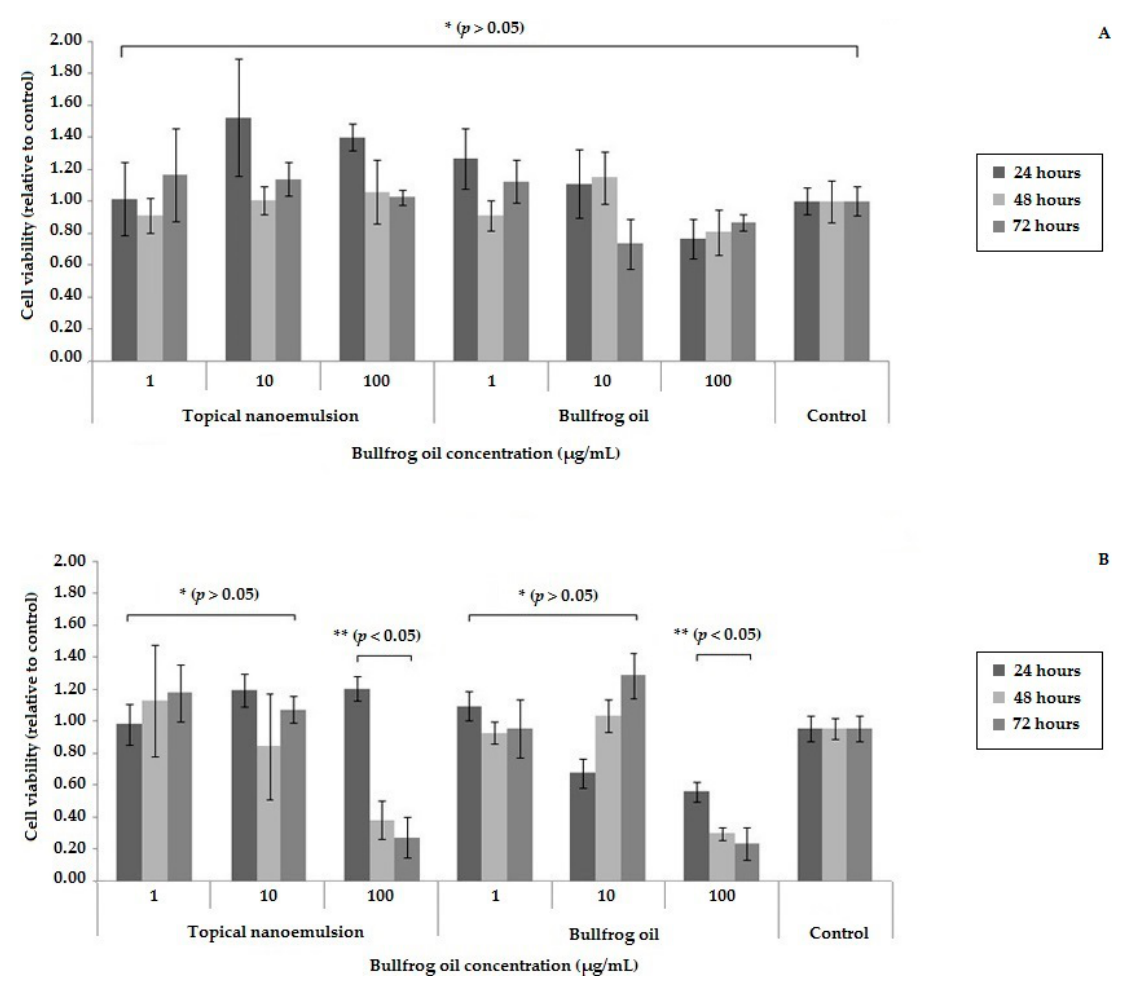
Figure 4. Cell viability of the topical nanoemulsion and the bullfrog oil at three concentrations. ( A ) 3T3 cell viability; ( B ) B16F10 cell viability. Dark gray: 24 h; Light gray: 48 h; Medium gray: 72 h. * No statistical difference compared to the control. ** Statistical difference compared to the control.